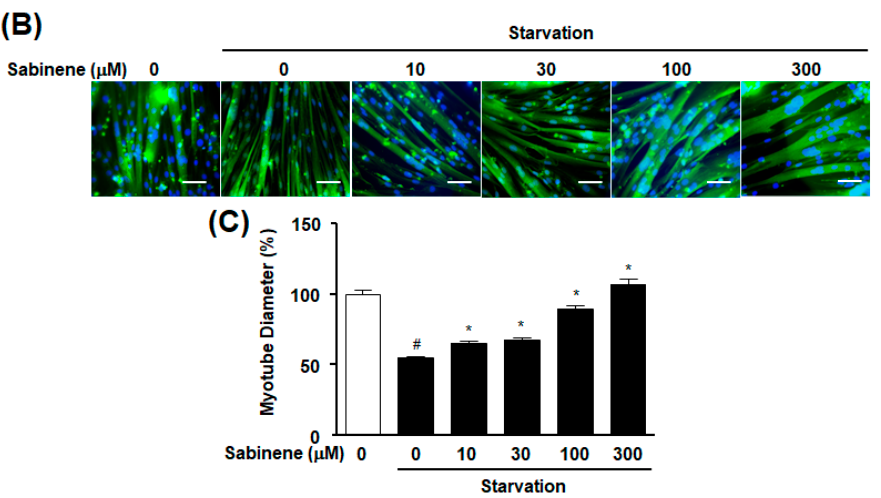
Figure 3. Effect of sabinene on atrophy of starved myotubes. ( A ) Effect of sabinene on myotube viability. L6 myotubes were incubated in the presence or absence of sabinene (10–2000 μ M) for 48 h, and cell viability was measured using an XTT assay. Cell response in the quiescent state was considered as 100% ( n = 16). * p < 0.05 vs. untreated cells. ( B,C ) Effect of sabinene on starvation-induced atrophy of L6 myotubes. L6 myotubes were incubated with serum-free DMEM in the absence or presence of sabinene (10–300 μ M) for 18 h and immunostained with anti-myosin heavy-chain (MYH)-2 and anti-DAPI antibodies. Diameters of myotubes were measured as described in Materials and Methods. Green and blue indicate MYH-2-positive myotubes and DAPI-positive nucleus, respectively. Scale bar: 100 μ m. ( B ) Representative images. ( C ) Statistical graph obtained from panel ( B ). Myotube size in the quiescent state was considered as 100% ( n = 12). * p < 0.05 vs. starved myotubes without sabinene treatment. # p < 0.05 vs. the quiescent state.